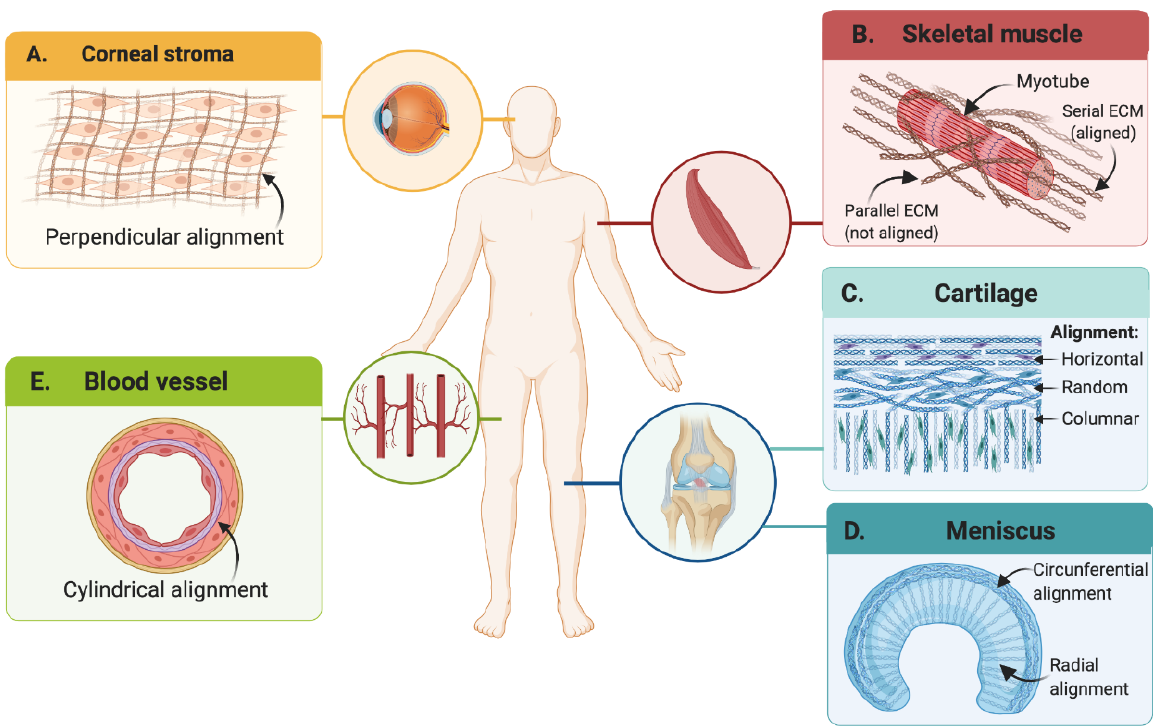
Figure 3. Examples of hierarchical cellular organization and ECM architecture in different native tissues. ( A ) Corneal stroma, ( B ) skeletal tissue, ( C ) cartilage, ( D ) meniscus, and ( E ) blood vessels (Created with BioRender.com).